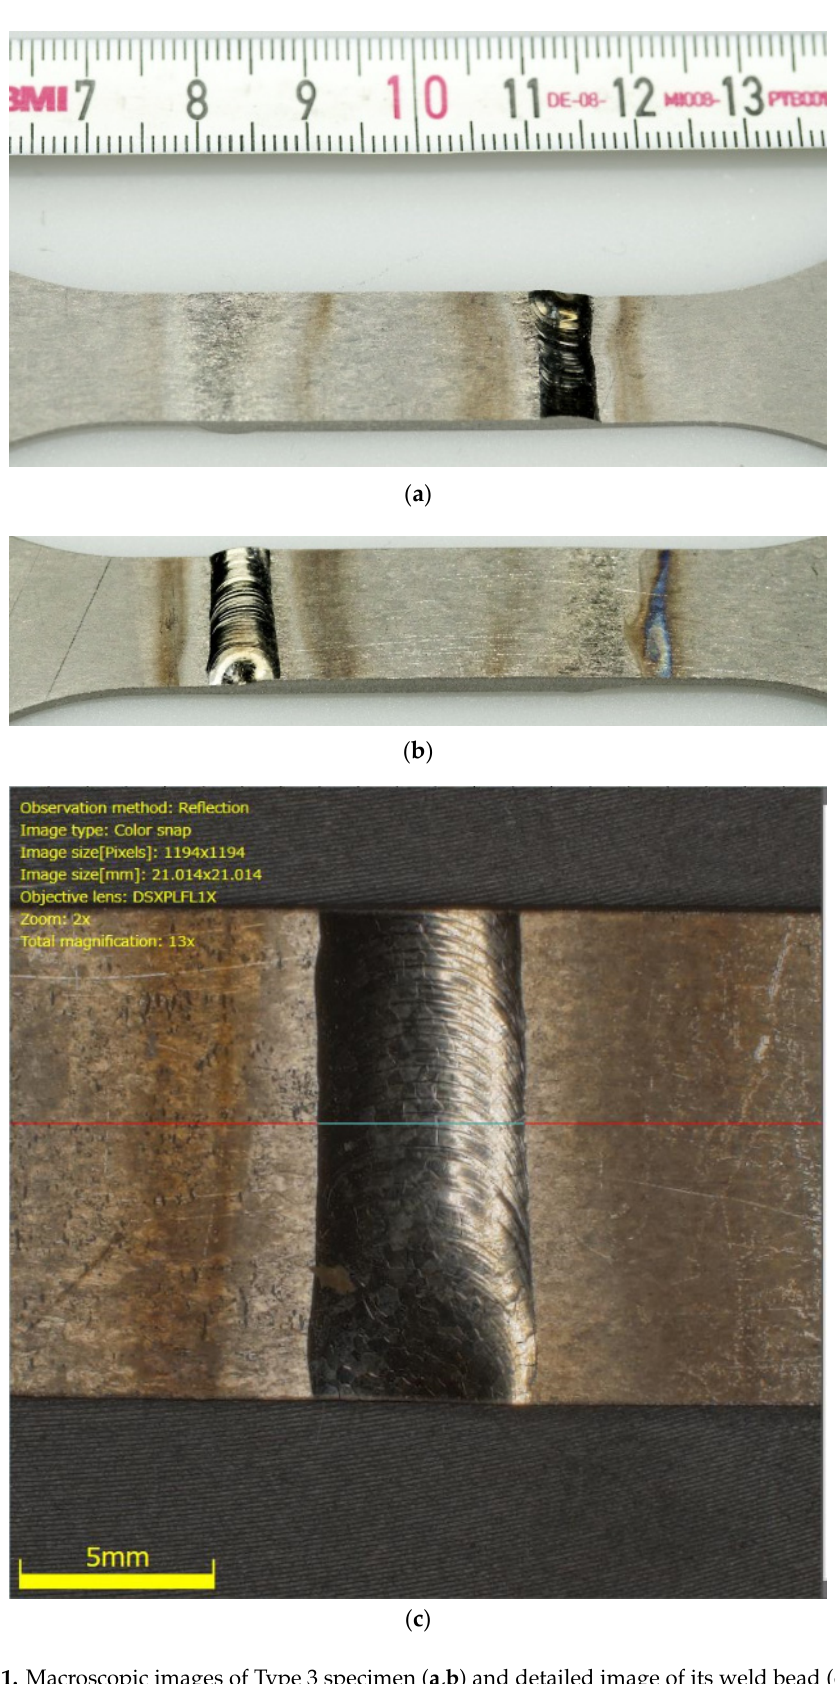
Figure 11. Macroscopic images of Type 3 specimen ( a , b ) and detailed image of its weld bead ( c ) before fatigue